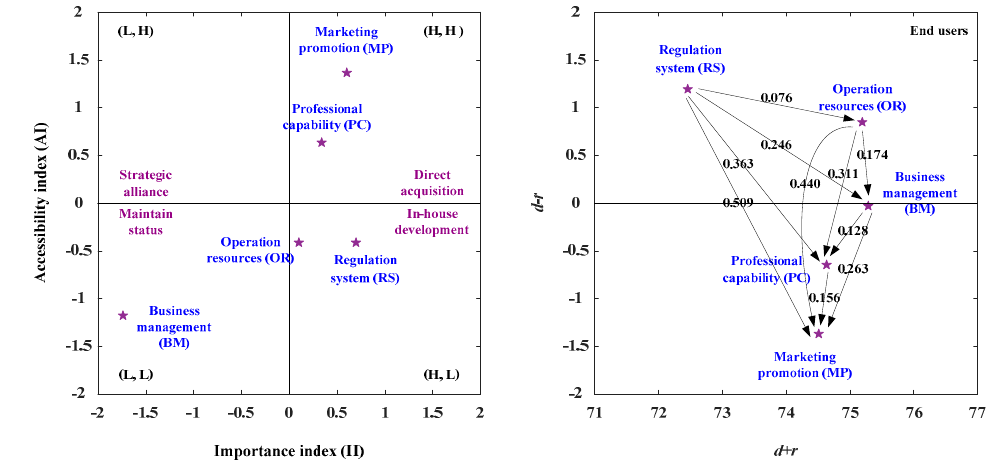
Figure 6. The IAA-NRM for end users. Table 15. The development strategy for end users.